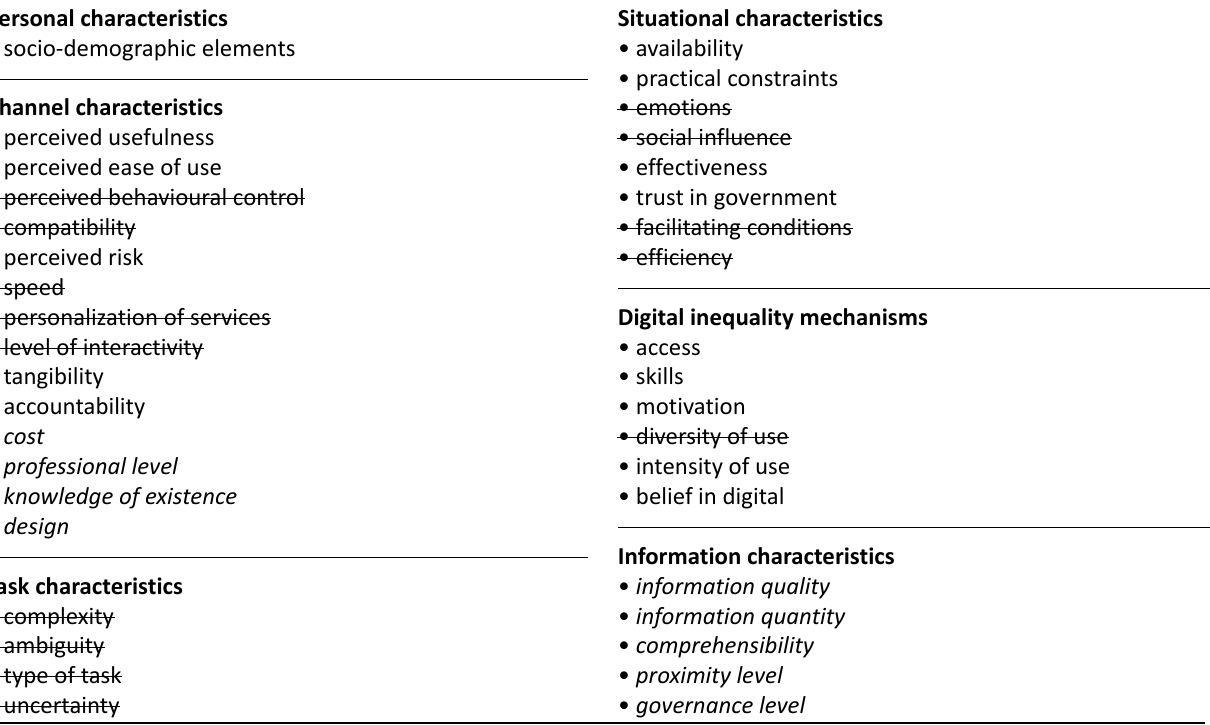
Table 2. Modified conceptual framework of channel choice. Personal characteristics